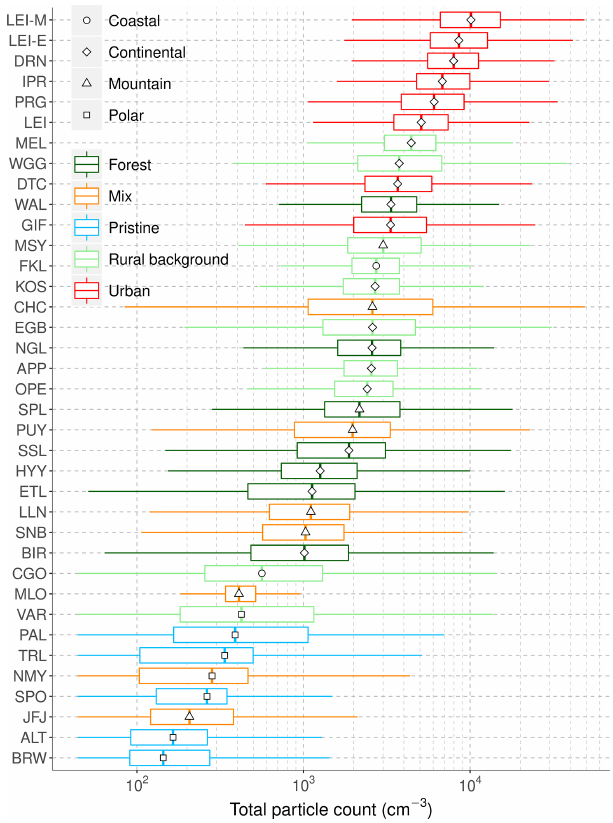
Figure 8. Yearly median of the total particle number concentration ( N tot ). The markers represent the median of the data and the lower and upper edges of the box indicate the 25th and 75th percentiles, respectively. The length of the whiskers represents the 1.5 interquar- tile range. Different markers and box colours indicate geographical categories and footprint, respectively, according to Table 3. Note that only the sites with sufficient annual coverage (i.e. > 75%) are